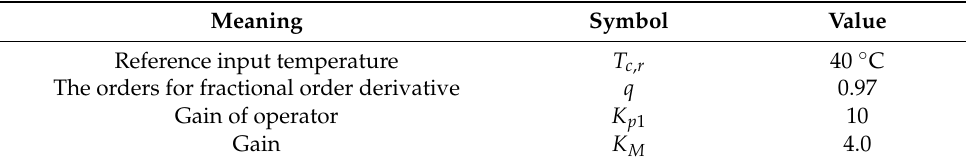
Table 3. Tuning parameters for operator controller.